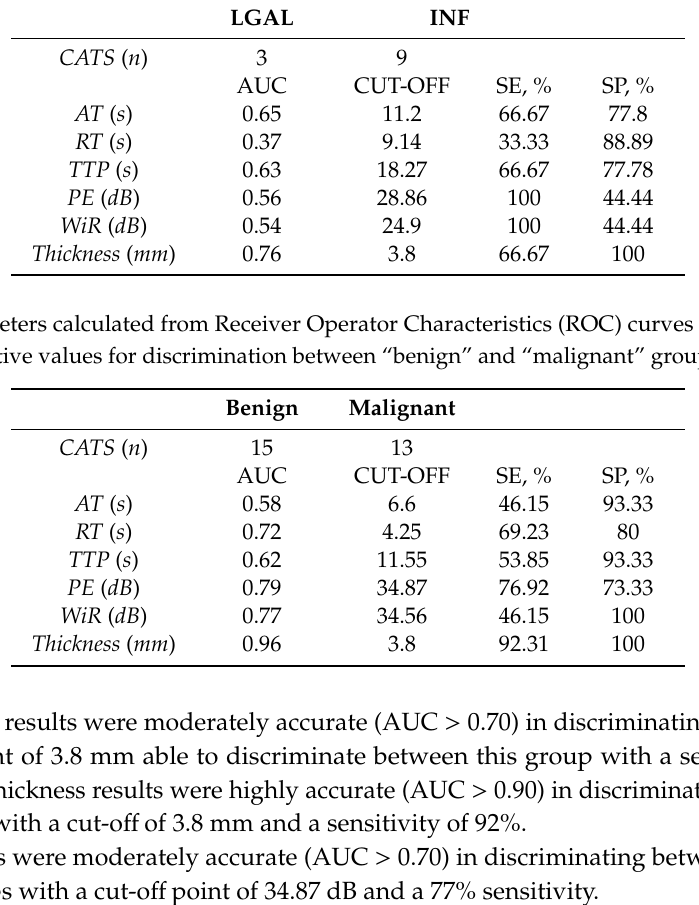
Table 5. Parameters calculated from Receiver Operator Characteristic (ROC) curves of B-mode and CEUS quantitative values for discrimination between low-grade alimentary lymphoma (LGAL) and inflammation (INF). LGAL INF